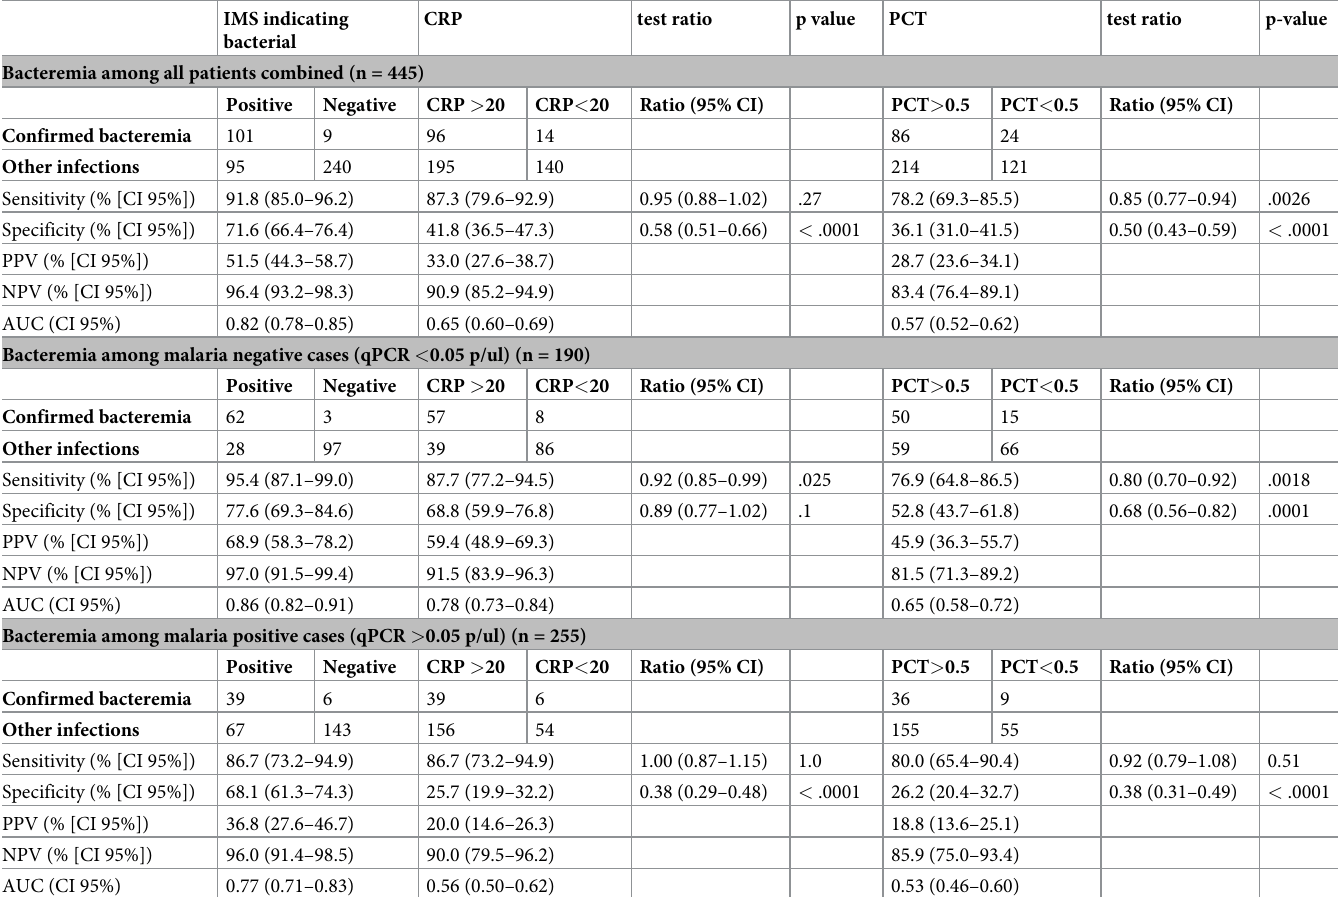
Table 5. Diagnostic accuracy of the IMS to detect bacteremia versus standard microbiological techniques among patients of all ages. Data are presented separately for malaria positive cases, malaria negative cases and all cases, and compared to accuracy of CRP and